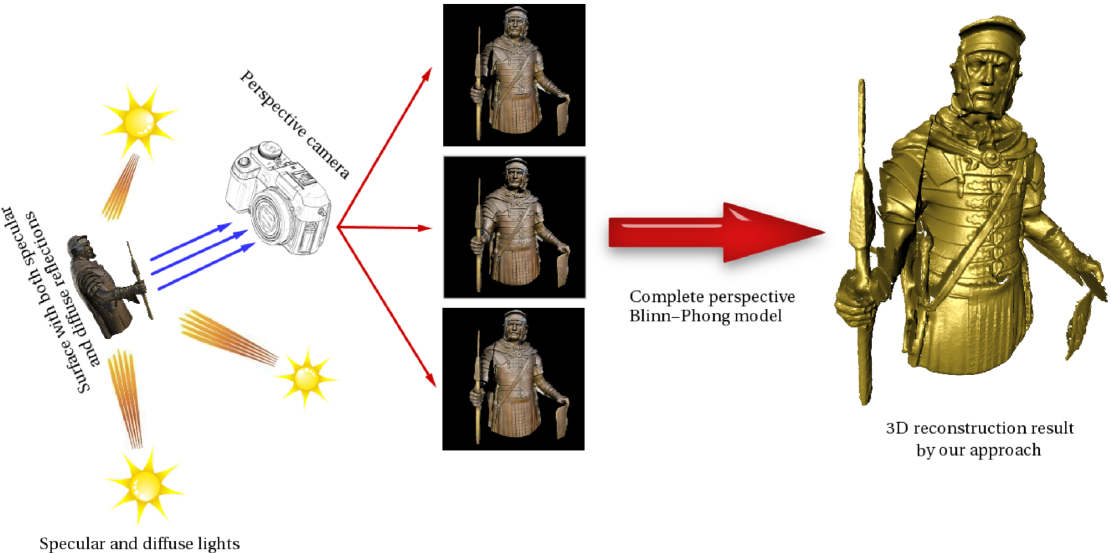
Fig. 1 Highly specular photometric stereo setup illustrated by a complex synthetic experiment. In the real world, surfaces show both specular and diffuse reflections, so considering only the diffuse component or only the specular component does not suffice for real world applications. This surface is illuminated by three non-coplanar light sources with both specular and diffuse lighting. Shading due to each light is captured in a perspective CCD camera. By considering all stated assumptions, we are able to recover shape with a high degree of surface